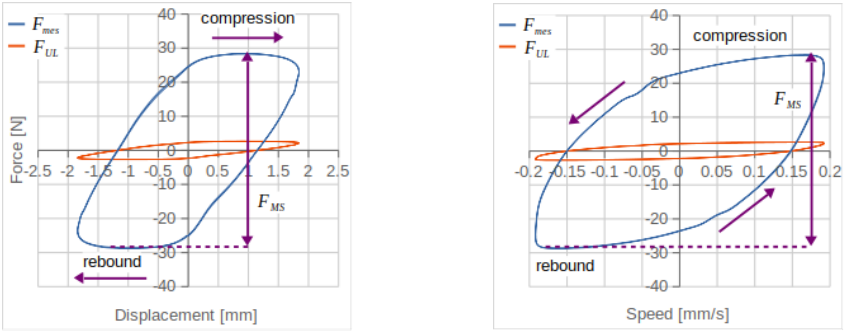
Figure 6. Representative force-displacement graph ( left ) and force-speed graph ( right ) of the single friction point floating piston/tube; with 𝐹 𝑚𝑒𝑠 showing measured friction and 𝐹 𝑈𝐿 showing the unit level friction contribution.